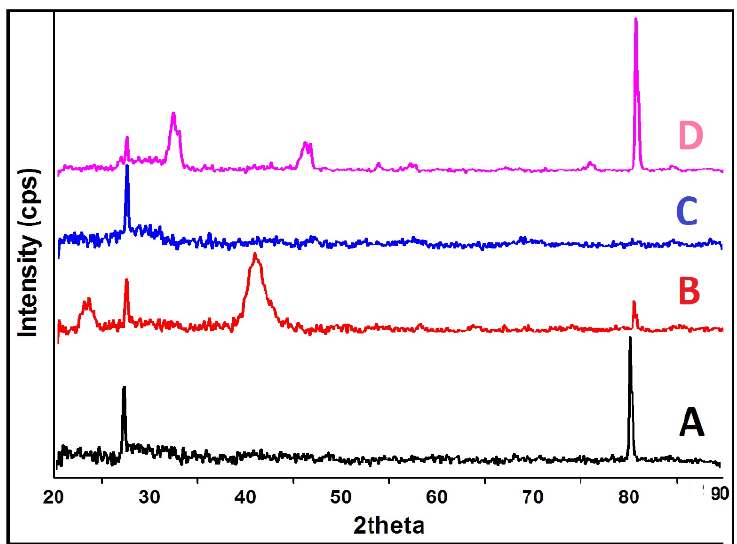
Figure 4. XRD analysis of ( A ) Keratin, ( B ) PVA, ( C ) GS, and ( D ) 1:4 composite Scaffold.